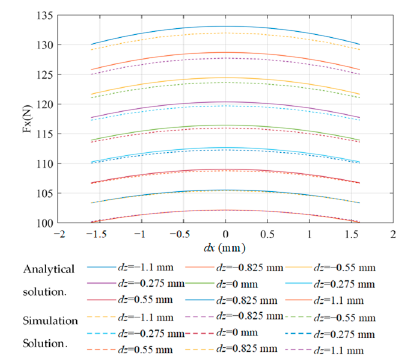
Figure 8. The relationship between the horizontal force of the coil and the displacement of the coil.